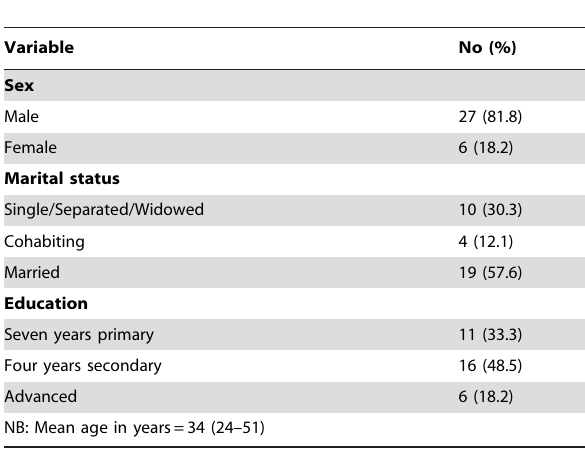
Table 3. Baseline characteristics of the study participants.